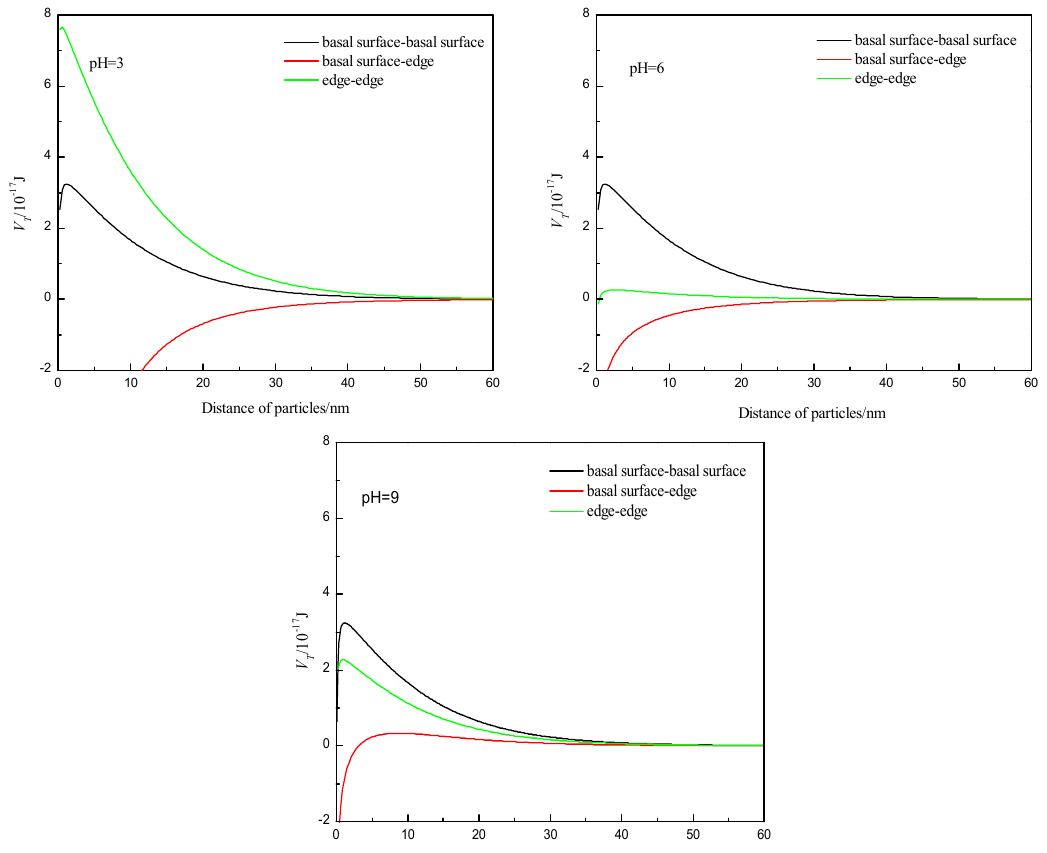
Figure 6. Total interaction energy of three kinds of form at different pH values.